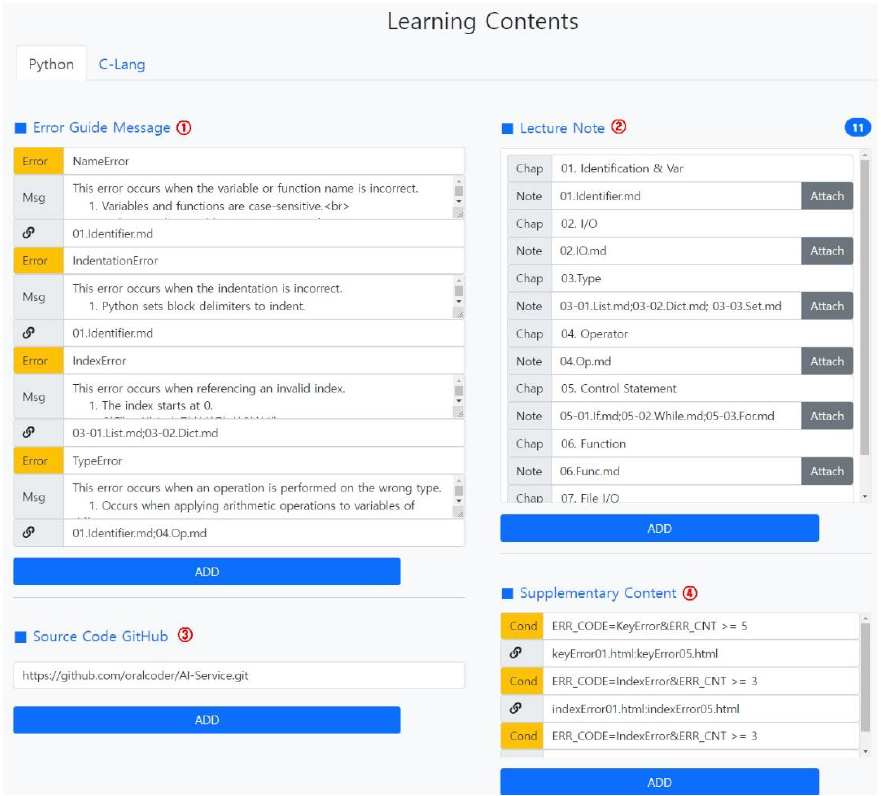
Figure 4. Learning support module interface. ① The error guide message allows the instructor